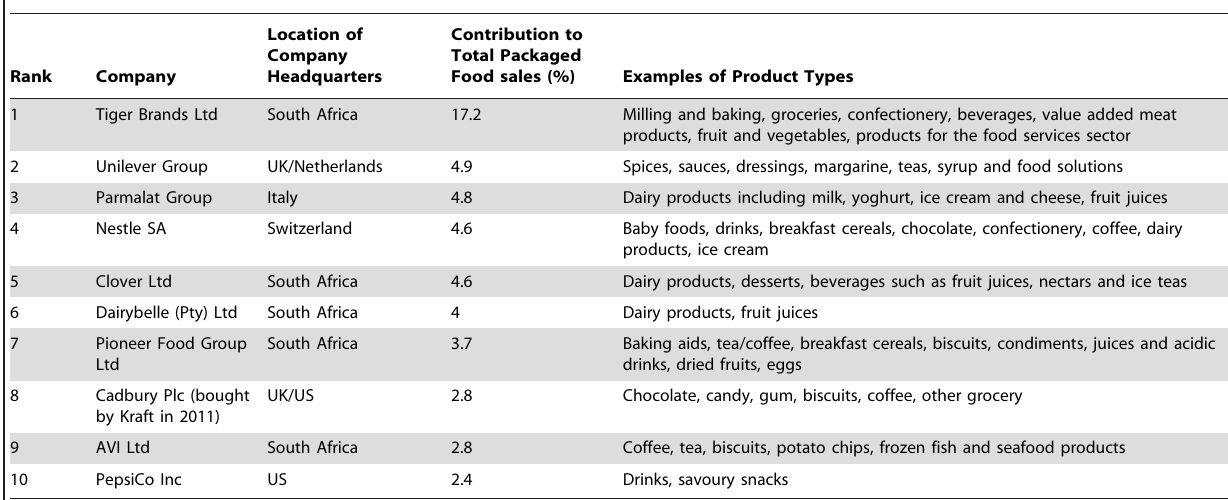
Table 2. Packaged Food Company Shares in South Africa, 2009.